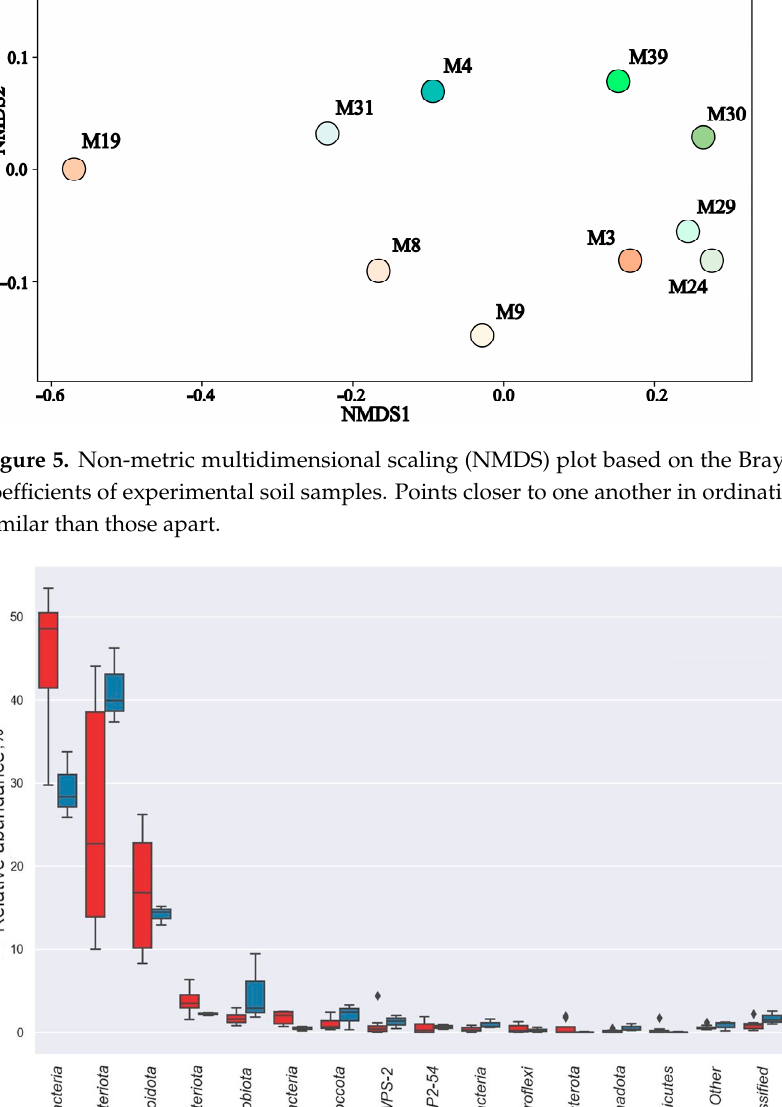
Figure 7. Distribution patterns of methylotrophs retrieved from the peat samples. At the same time, methanotrophic Proteobacteria Methylobacterium - Methylorubrum and facultatively methylotrophic psychrotolerant bacterium Methylorosula were detected only in the anthropogenically disturbed objects, and the proportion of methanotrophic verrucomicrobia was significantly lower. The data obtained convincingly indicate changes in microbial communities of the methane cycle under anthropogenic influences, which allows us to consider them as indicators for environmental monitoring.